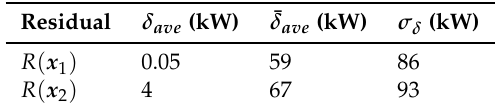
Table 4. Statistical behavior of the residuals between measurement and estimation for the different random choices of the ˆ D 0 and ˆ D 1 data